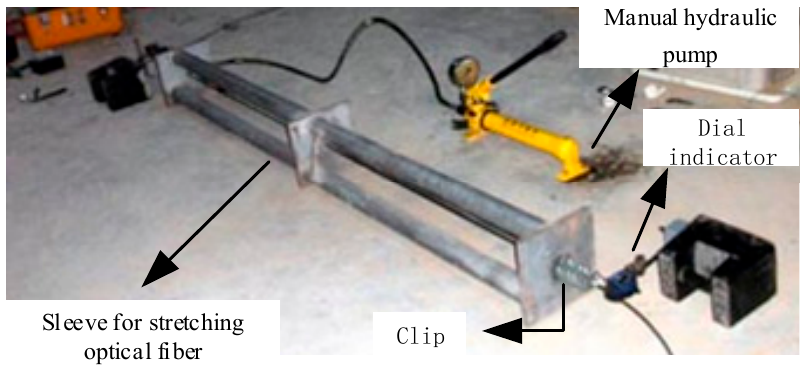
Figure 11. Optical fiber drawing device platform.